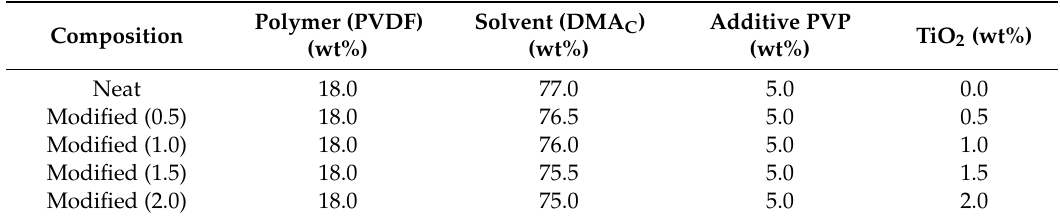
Table 1. Dope chemical